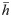
Panel (a) shows how depending on the value of s the inverted rank can give a higher value of h¯ than the planted rank in military-like graph with parameters p = 0.5, q = 0, R = 32. Panel (b) gives a schematic representation of the estimated optimal number of classes R˜* as s varies, dashed lines are associated to the inverted rank.